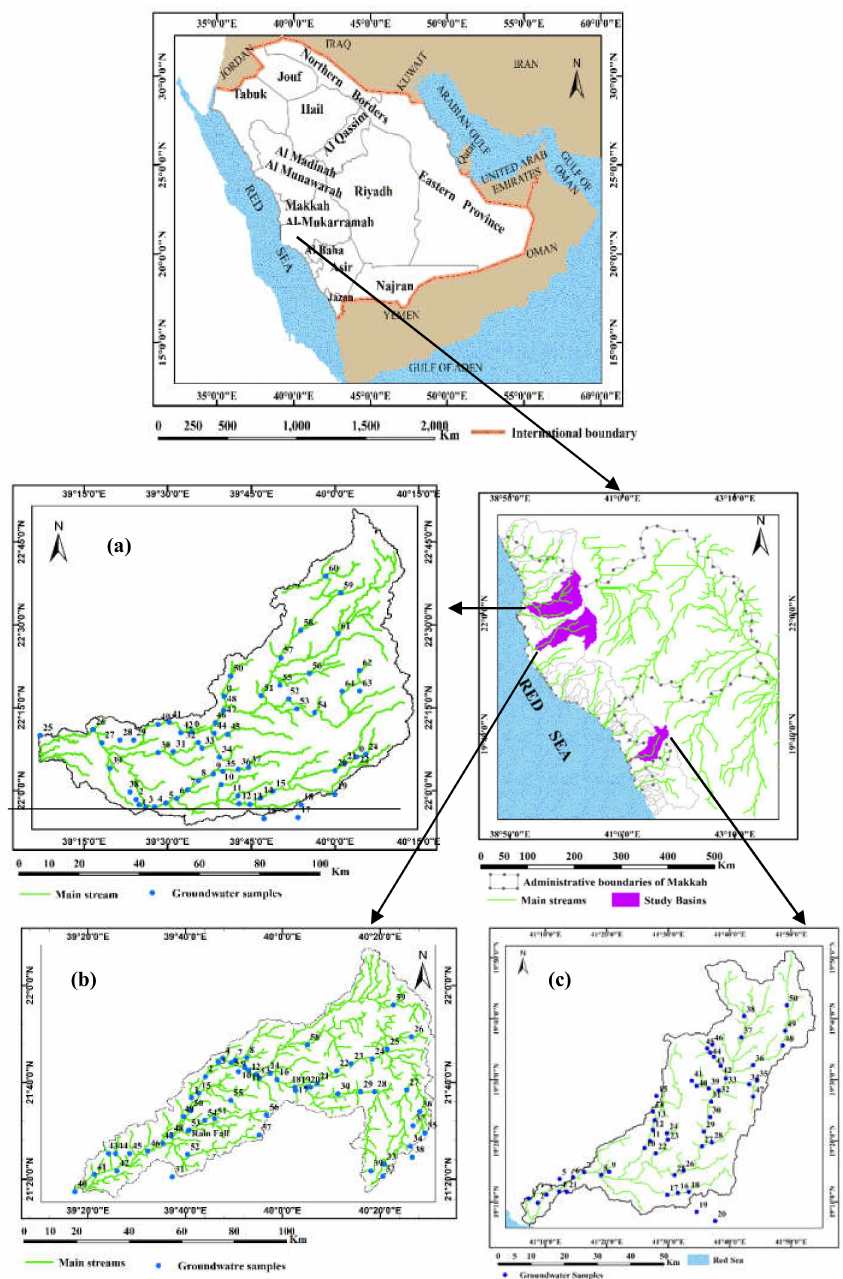
Figure 1. Location map of the groundwater points for the selected wadies in Makkah Al-Mukarramah Province, Saudi Arabia: ( a ) Wadi Marawani, ( b ) Wadi Fatimah, and ( c ) Wadi